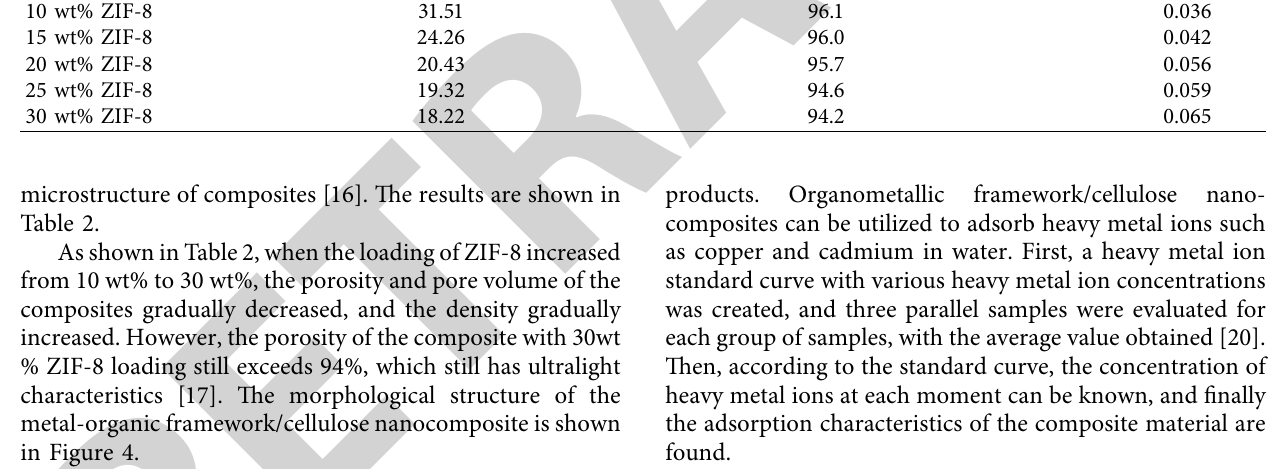
Table 2: Effect of ZIF-8 content on the microstructure of composites.